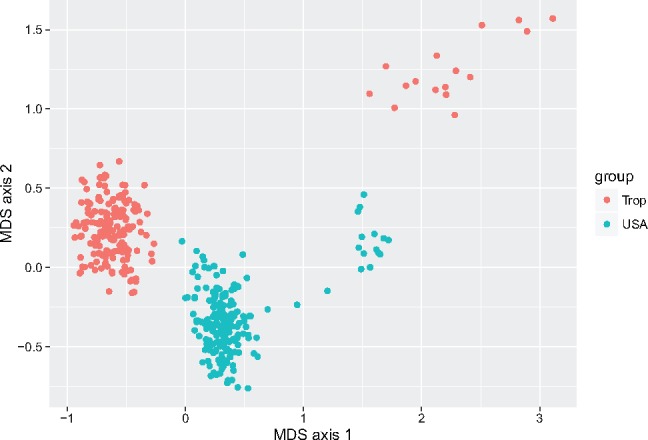
Multidimensional scaling plot derived from distances \documentclass[12pt]{minimal}
\usepackage{amsmath}
\usepackage{wasysym}
\usepackage{amsfonts}
\usepackage{amssymb}
\usepackage{amsbsy}
\usepackage{upgreek}
\usepackage{mathrsfs}
\setlength{\oddsidemargin}{-69pt}
\begin{document}
}{}$\hat{d}$\end{document}, containing a weighted combination of the shape distance and a length-based comparison of the ratio between the mean terminal branch length and the mean internal branch length in each tree.